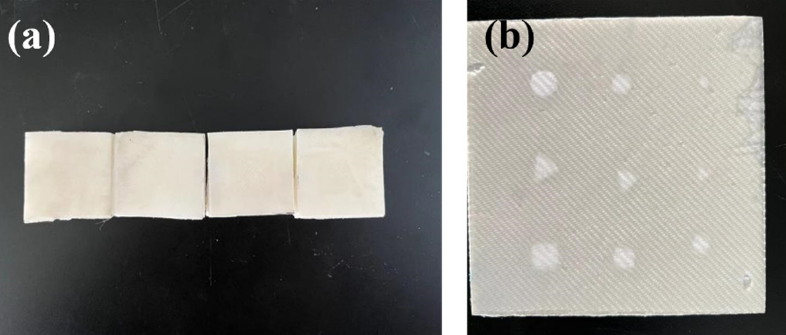
Figure 7. Physical picture of the sample: ( a ) part of the training set samples and ( b ) a sample of the test network.